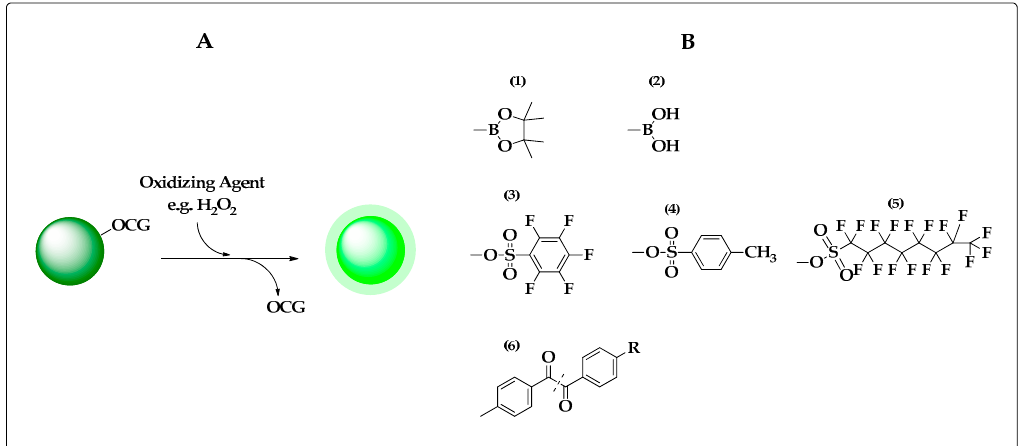
Figure 2. Oxidative cleavage reaction for H 2 O 2 detection. ( A ) Schematic representation of the oxidative cleavage of a quenching group (oxidative cleavage group (OCG)) from a dye molecule (green). The product can be excited and emits light at a specific wavelength; ( B ) Frequently used OCG for H 2 O 2 detection; ( 1 ) and ( 2 ) are boronate-based, ( 3 – 5 ) are sulfonate based; and ( 6 ) is based on the insertion of H 2 O 2 and subsequent cleaving of the C–C bond (indicated by dashed line).